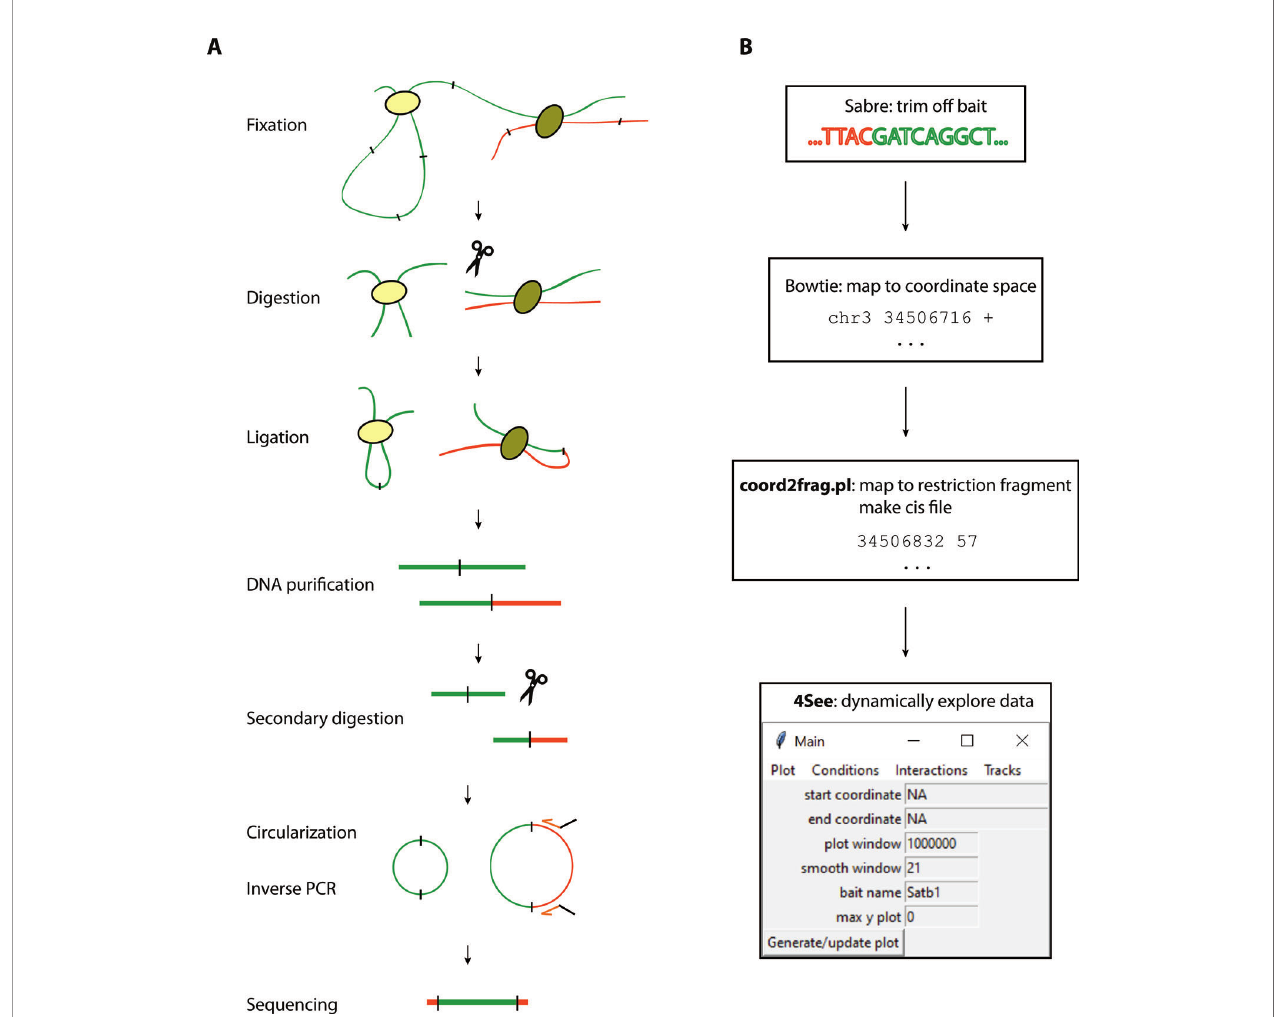
FIGURE 1 | Overview of the 4C method and analysis. (A) The 4C method entails chromatin fi xation, restriction digestion and re-ligation to generate hybrid sequences between fragments that were physically proximal during fi xation. The DNA is puri fi ed, digested with a secondary restriction enzyme and re-ligated under dilute conditions to generate DNA circles. Chimeric products linked to a speci fi c bait fragment of interest (orange) are ampli fi ed by inverse PCR with bait-speci fi c primers (orange arrows) fl anked by Illumina sequencing adapters (black overhangs). The PCR products are then directly loaded onto Illumina fl ow-cells for high- throughput sequencing. (B) Pre-processing steps before 4See; tools denoted in bold accompany this manuscript. The fastq sequences are fi rst trimmed to remove bait restriction fragment sequence (orange), leaving just the prey DNA sequence (green) for mapping to the reference genome with Bowtie. The mapped genomic coordinates are converted to restriction fragment space by a custom perl script, which counts the total number of reads mapping to each fragment on the same chromosome as the bait. This “ cis ” fi le can then be directly input into